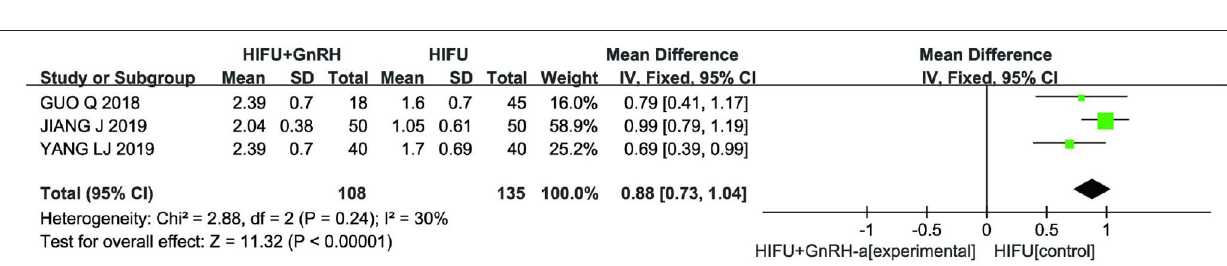
FIGURE 8 | Meta-analysis of menstrual volume scores in two groups.